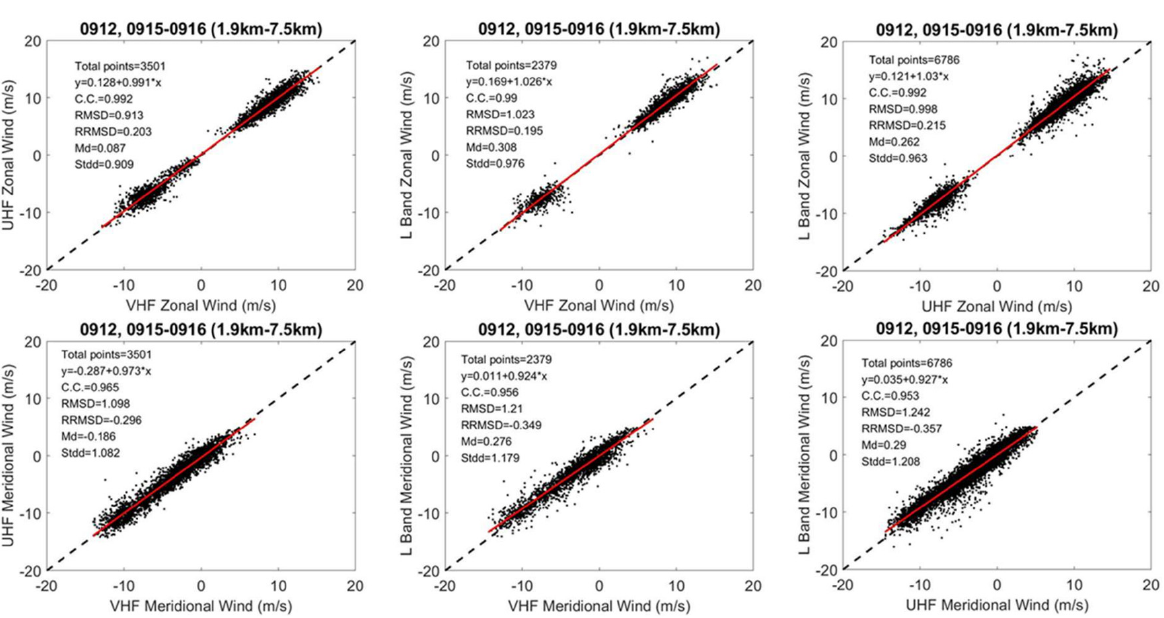
Figure 4. Comparisons of zonal ( upper ) and meridional ( lower ) wind velocities measured by 52 MHz VHF radar, 449 MHz wind profiler, and 1290 MHz wind profiler for clear air conditions.